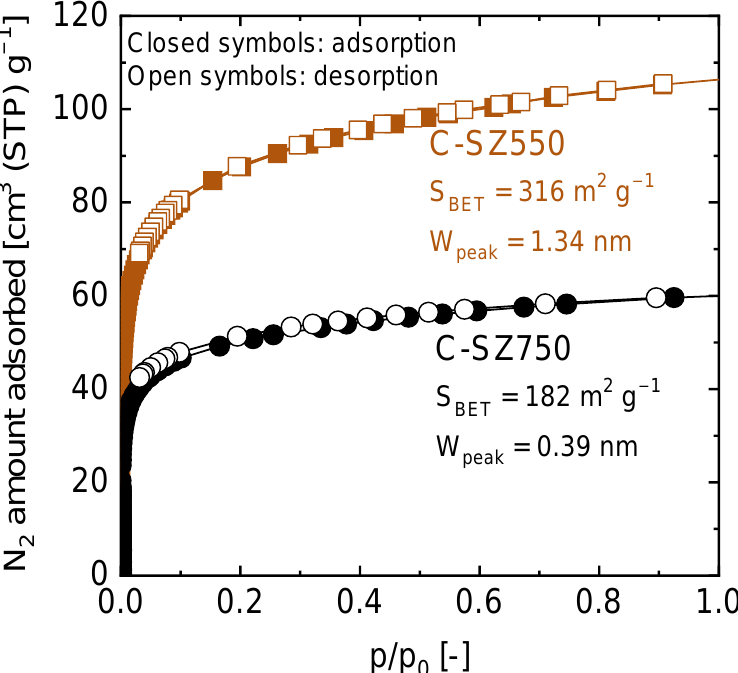
Figure 5. Nitrogen adsorption and desorption isotherms at 77 K of carbon-SiO 2 -ZrO 2 (C-SZ) powders derived from 200 °C-cured SiO 2 -ZrO 2 -polybenzoxzine resins after pyrolysis at 550 and 750 °C (S BET : Bruneuer – Emmett – Teller surface area; W peak : peak pore width).